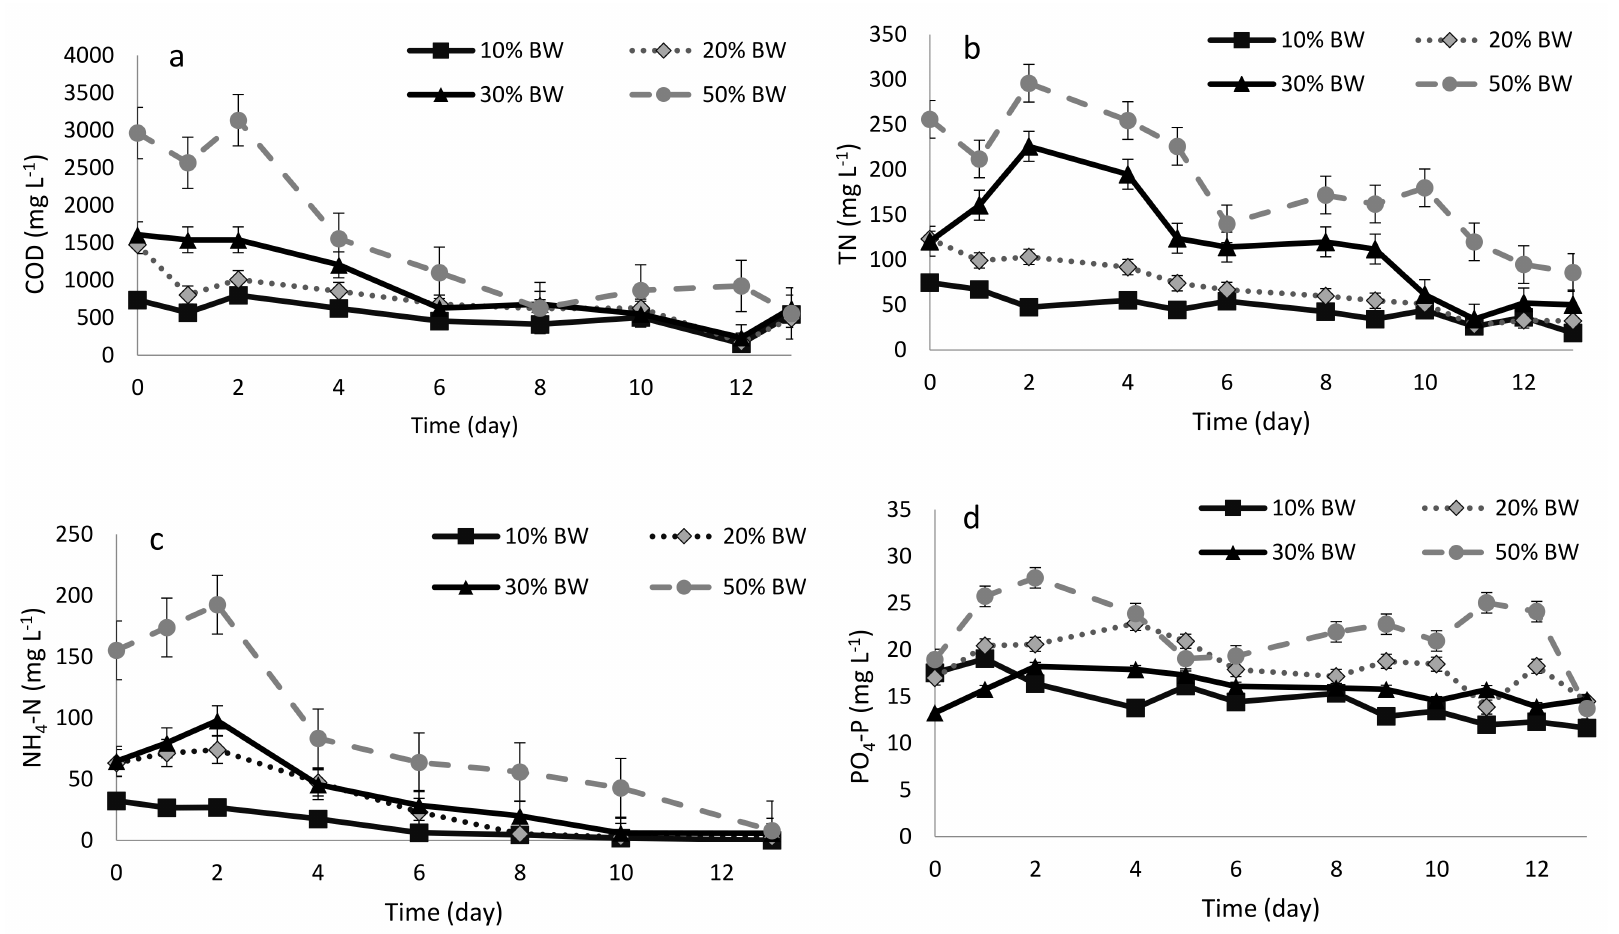
Figure 2. Concentration trends of chemical oxygen demand (COD) ( a ), total nitrogen (TN) ( b ), ammonium-nitrogen (NH 4 -N) ( c ), and orthophosphate (PO 4 -P) ( d ) in di ff erent dilutions of blackwater (BW) ( n =